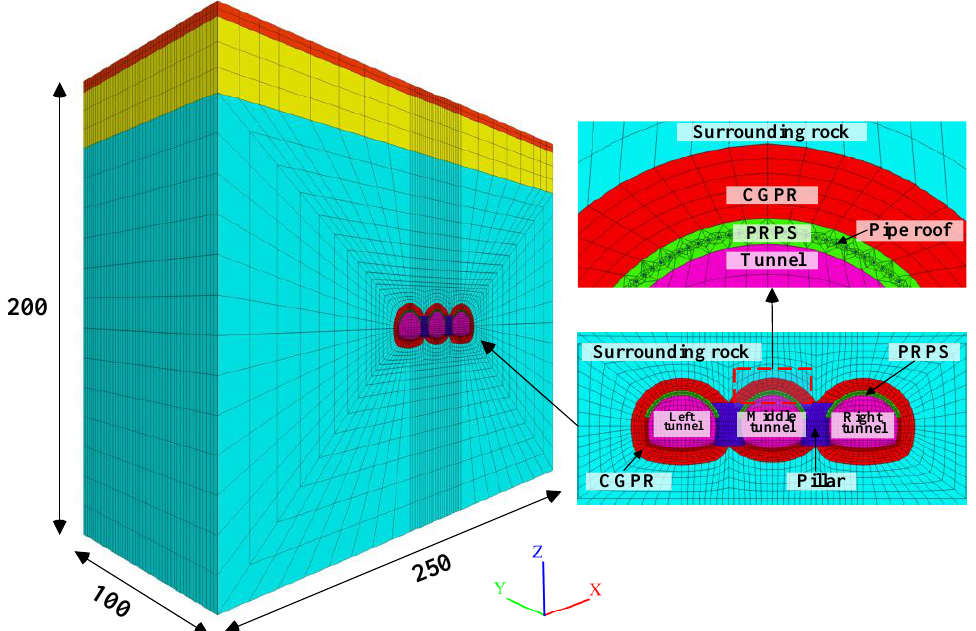
Figure 9. Three-dimensional finite element model of triple tunnels.